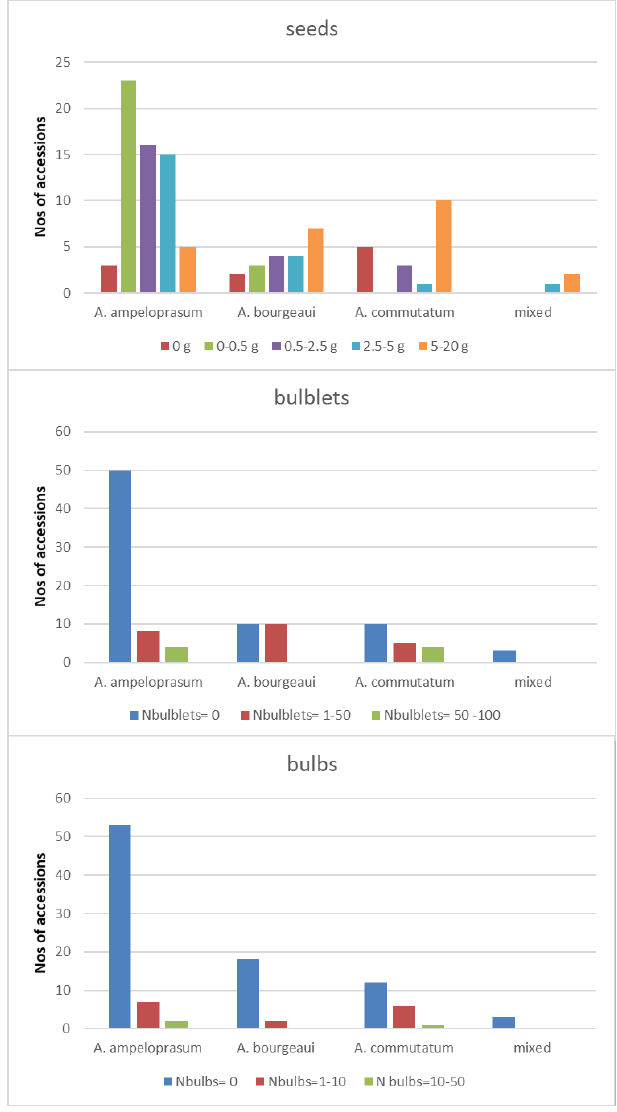
Figure 6. The quantity of seeds and the number of bulblets and bulbs sampled in the various leek CWR populations. When a category on the X-axis is presented as an interval the lower value is excluded from the interval and the higher value is